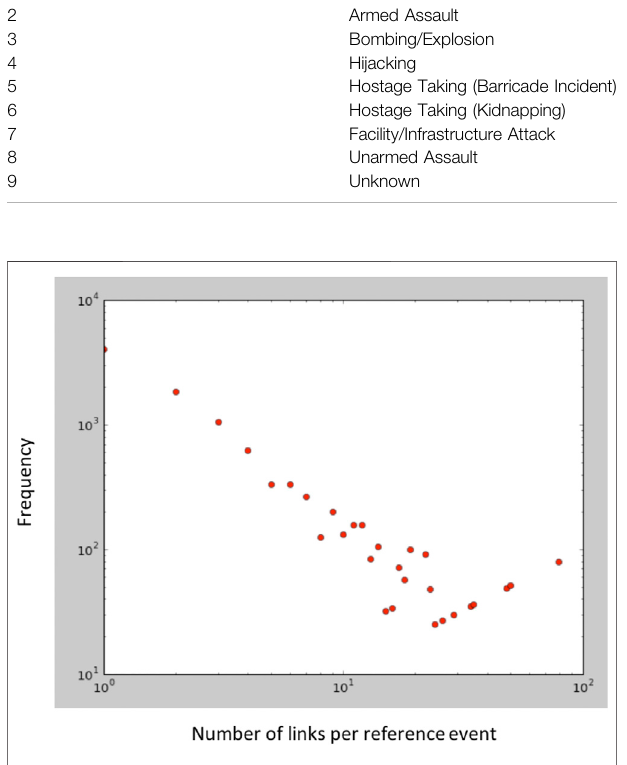
FIGURE 2 | GTD link prediction ground-truth frequency